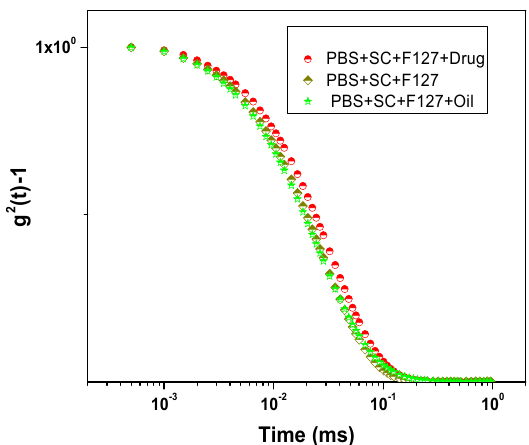
Fig. 10. the autocorrelation function of F127 microemulsions as a function of relaxation time at RT.